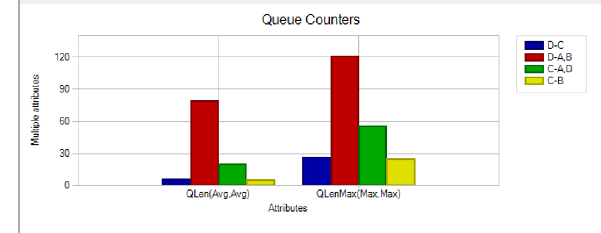
Figure 9: Average and maximum length of the vehicle line: direction C and